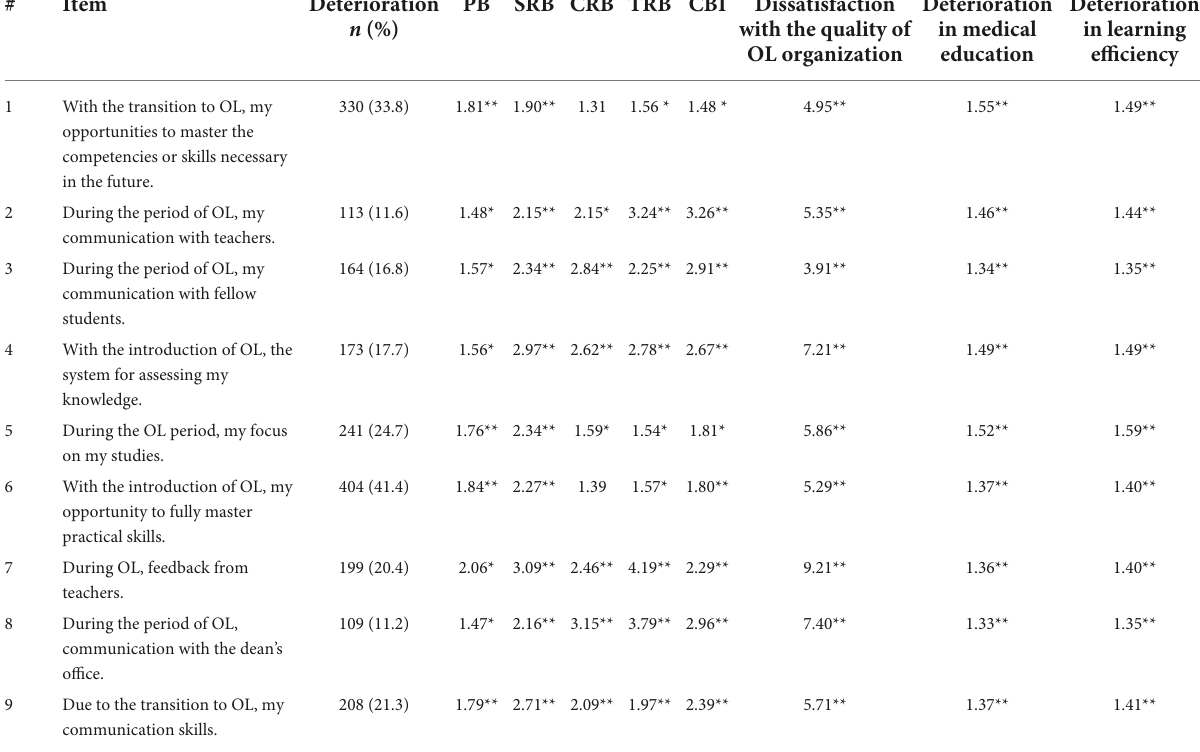
TABLE 4 Changes associated with the transition to OL during the COVID-19 pandemic and the association of deterioration with burnout, dissatisfaction with the quality of OL organization, and deterioration in medical education and learning efficiency on log-linear regression analysis ( N =